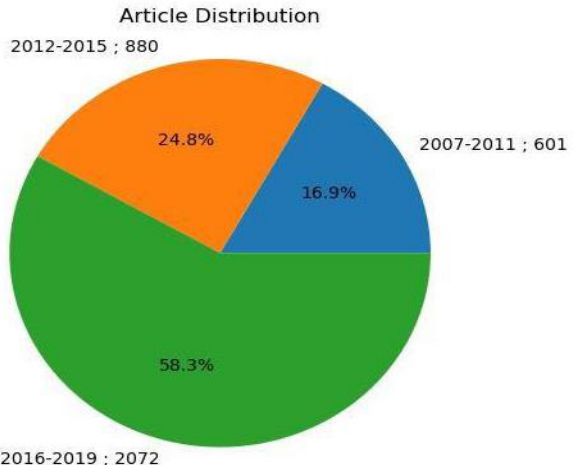
Figure 6. Research articles distribution according to three time spans.